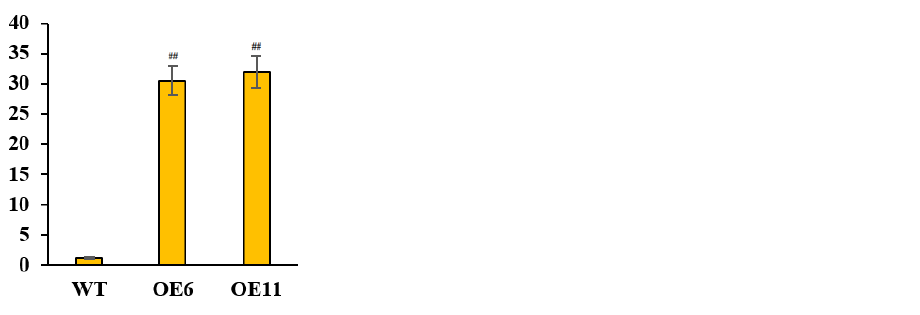
Figure 5. Expression intensity of MdUGT83K2 OE lines (normal culture for 3 weeks). Note: # p < 0.05, ## p < 0.01, n = 3.